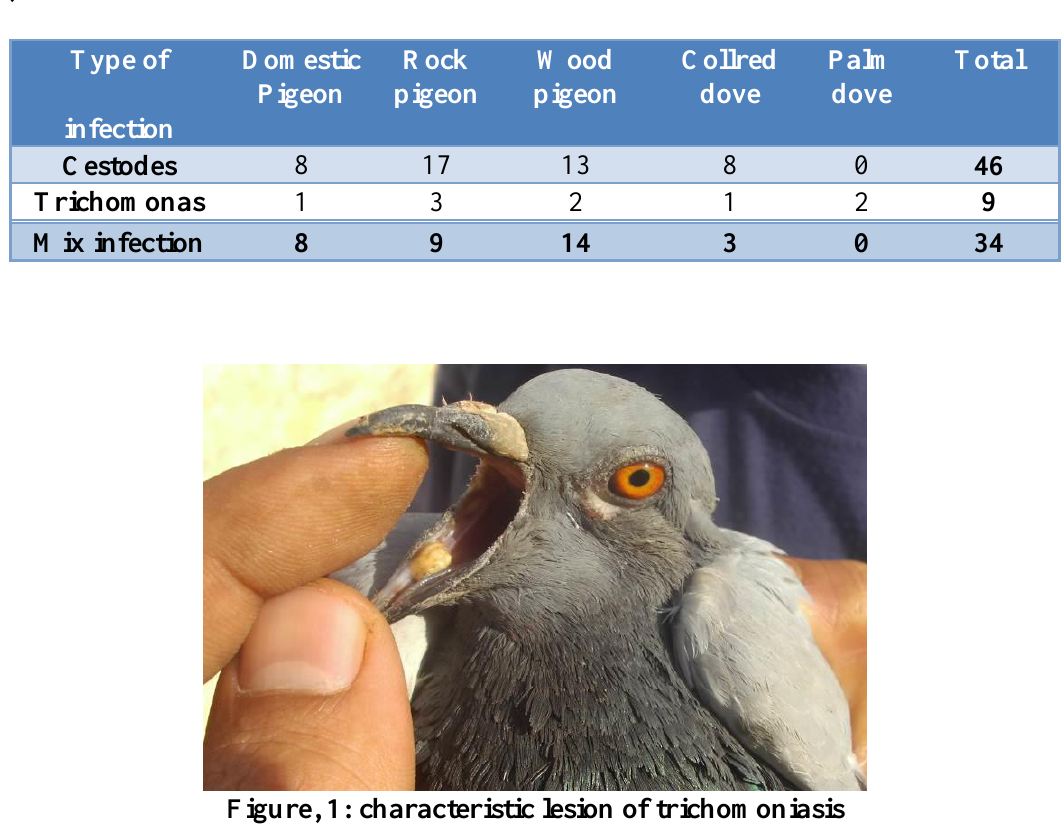
Table, 6: The number and percentage of cestode genera in columbides No. of infected bird (average of parasite/birds) Cestodes Domestic Rock Wood Collared Palm Tota Pigeon Pigeon Pigeon dove Dove l Raillietina spp. 16 (5.6) 25 (4.3) 26 (2.25) 12 (1.4) 0 79 Aporina spp. 6 (3.1) 5 (1.4) 9 (2.23) 3 (2.34) 0 23 Cotugnia spp. 8 (1.61) 5 (2.6) 8 (3.87) 0 0 21